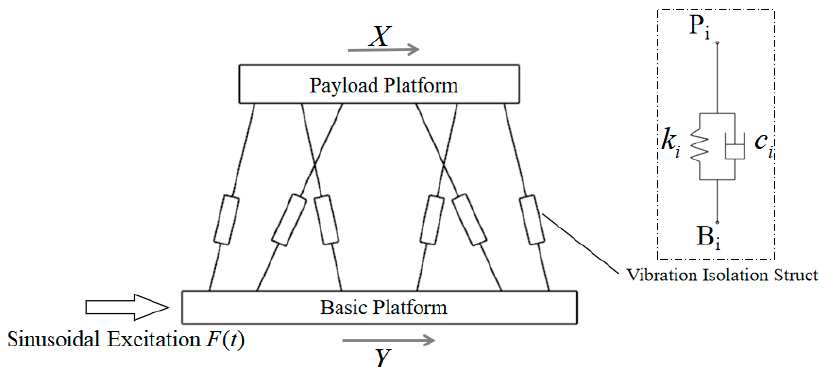
Figure 2. Vibration isolation principle of Stewart platform.